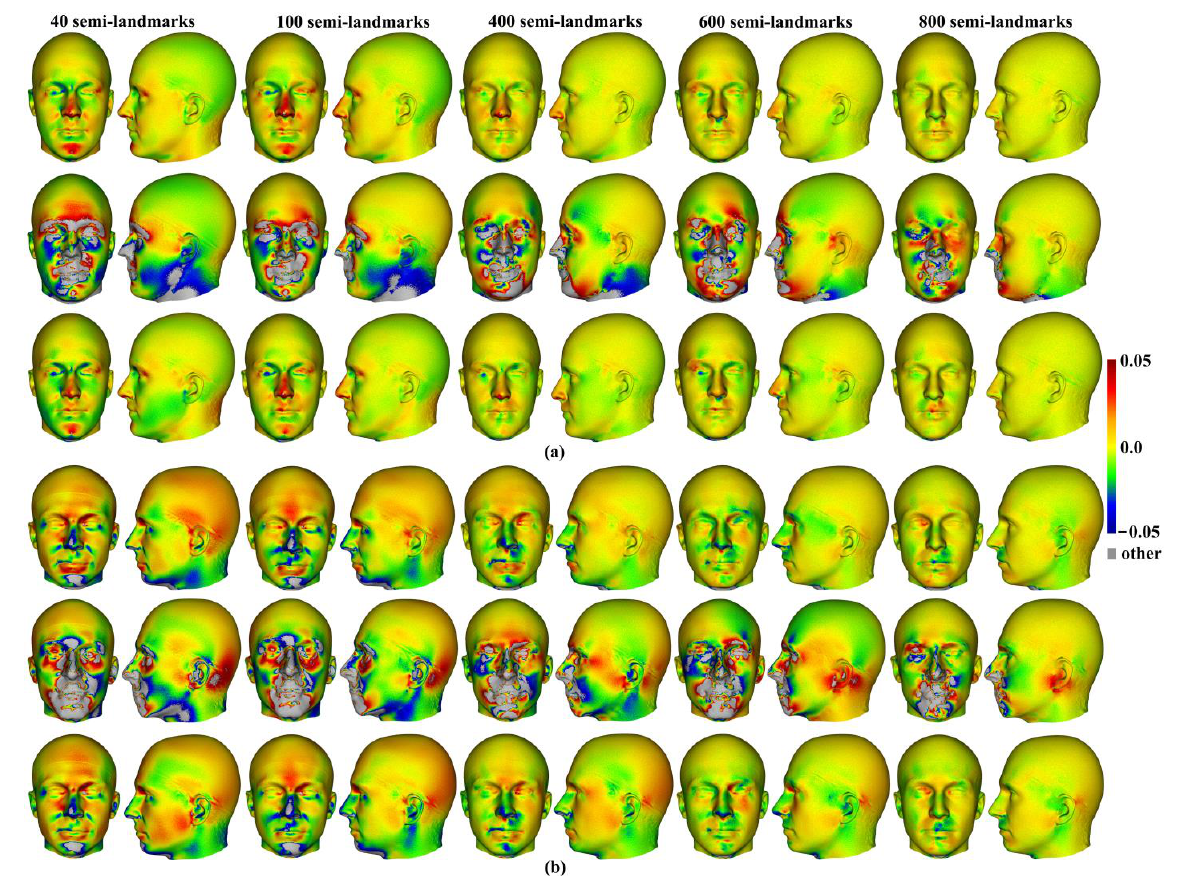
Table 8. Procrustes distances between vertices of the estimated predictions of ape cranial surfaces at the maximum and minimum centroid sizes derived from the maximum density of semilandmarks and those from lower densities of semilandmarks after re-semilandmarking and re-warping. Figure 20. Colour map of local area differences computed between the re-semilandmarked and re-warped allometric predictions of surfaces of human heads at the ( a ) maximum and ( b ) minimum sample centroid sizes, computed between lower densities (reference) and the maximum density (target) of semilandmarking. In each figure — top row: sliding TPS; middle row: LS&ICP; bottom row: TPS&NICP. Scale bar indicates difference in local area between reference and target surfaces expressed as a proportion of the reference area.